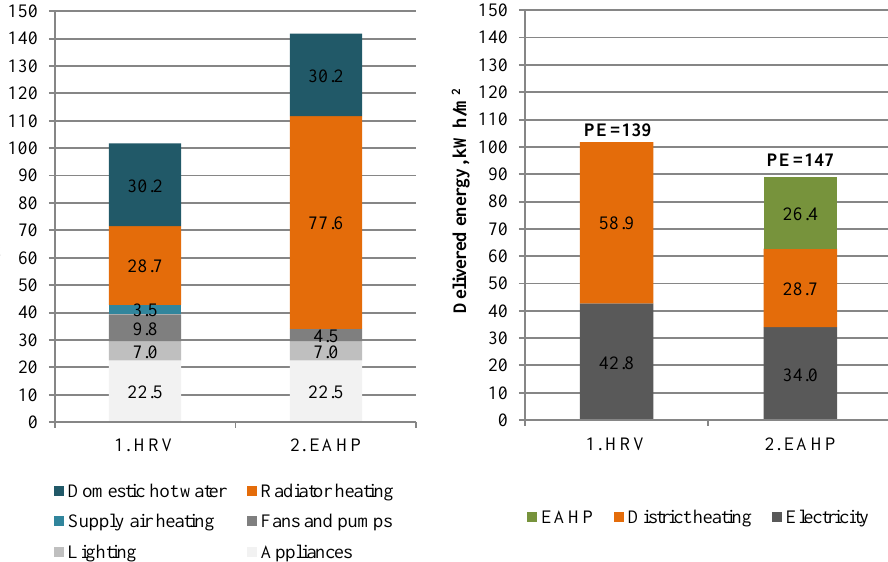
Fig. 1. Energy needs (demand) and initial delivered (purchased) and primary energy in the HRV (Option 1) and EAHP (Option 2)